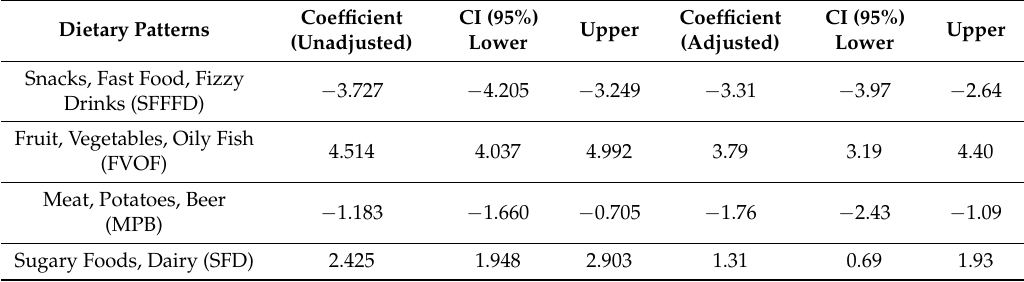
Table 7. Main effects (95% confidence intervals, p < 0.001) of the NDQS and dietary patterns (unadjusted and